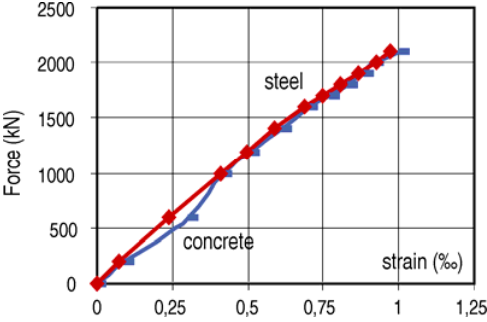
Fig 8 . Strains of steel and concrete in the middle height of composite column loaded over the whole composite cross-section